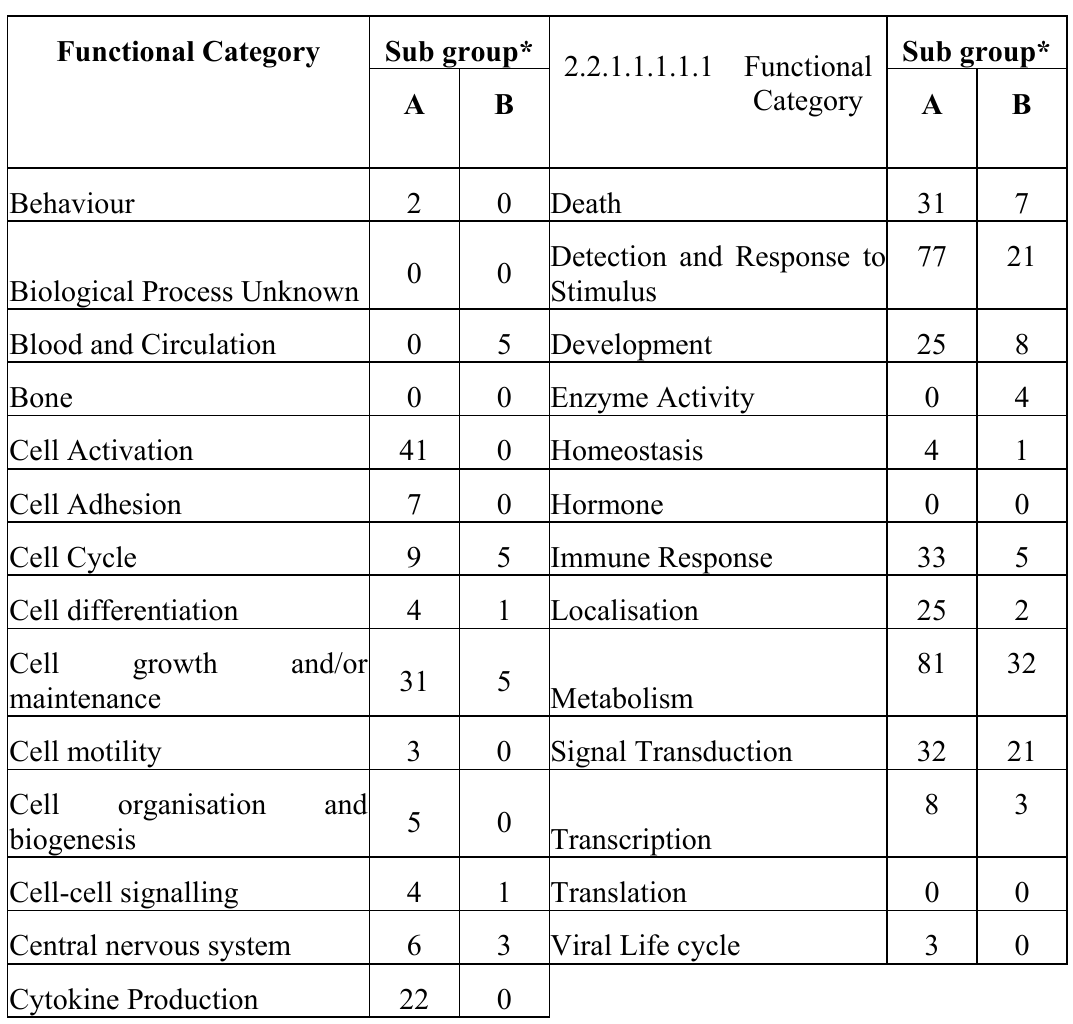
*Sub-groups A represent the number of subgroups within the functional category containing upregulated genes from the T2 dataset. Sub-groups B represent the number of subgroups within the functional category containing downregulated genes from the T2